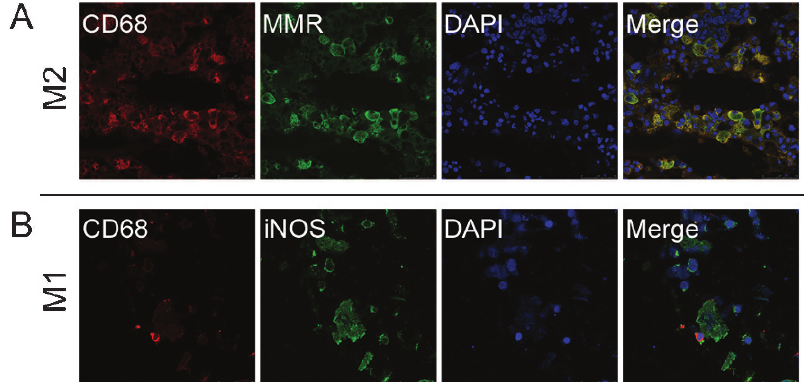
Figure 2 - M2- and M1-polarized TAMs in lung adenocarcinoma. (A) The coexpression of CD68 and MMR in TAMs in human lung adenocarcinoma sections. (B) The coexpression of CD68 and iNOS in TAMs in human lung adenocarcinoma